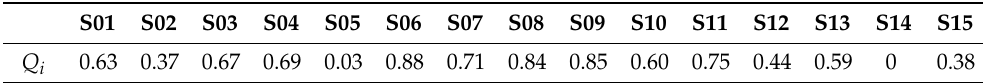
Table 15. The values of the fuzzy-VIKOR